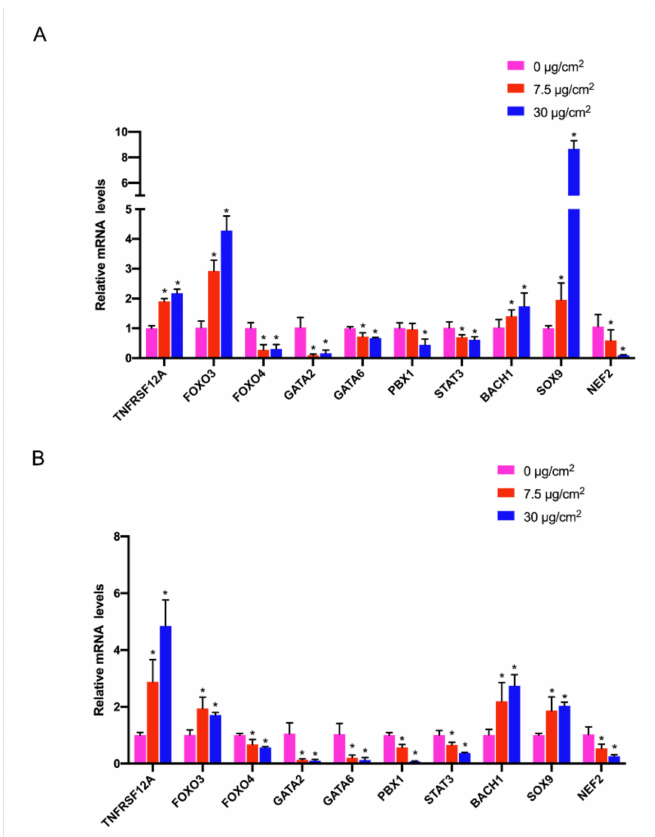
Figure 6. Gene expression validation by qRT-PCR. ( A , B ): Gene expression of BEAS-2B cells ( A ) and HPAEpiC cells ( B ) after exposure to different concentrations of PS-NPs through qRT-PCR validation. * p -value < 0.05 indicates statistically significant differences from the